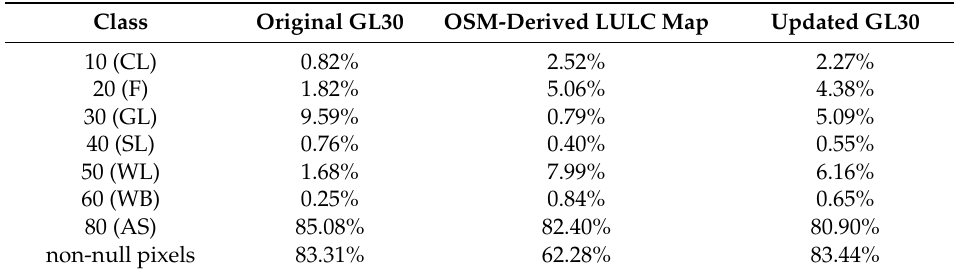
Table 8. Distribution of LULC classes and percentage of non-null pixels in the original GL30, the OSM-derived LULC map and the updated GL30 for Dar es Salaam study